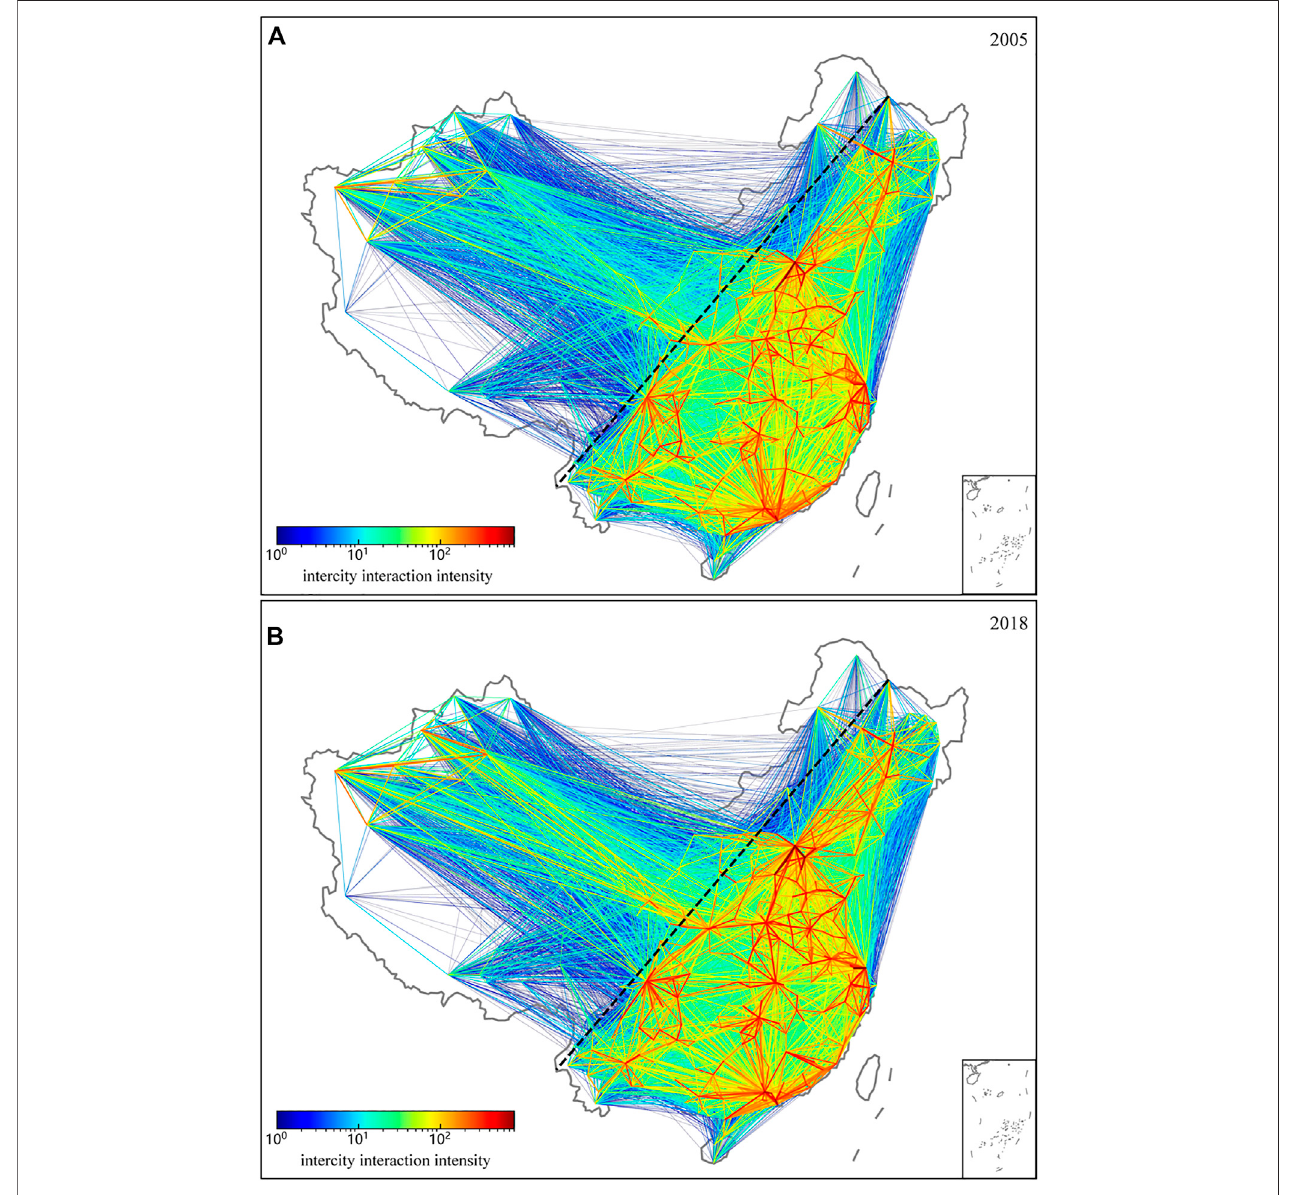
FIGURE 3 | Distribution of interaction intensity among Chinese cities (A) 2005. (B) 2018. The black dashed line is the Heihe-Tengchong line. The thickness and color of the other lines indicate the intercity interaction intensity.